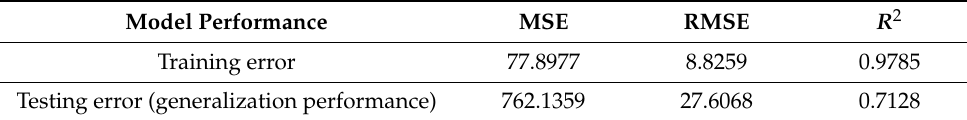
Table 12. The performance of the optimal KNN model.